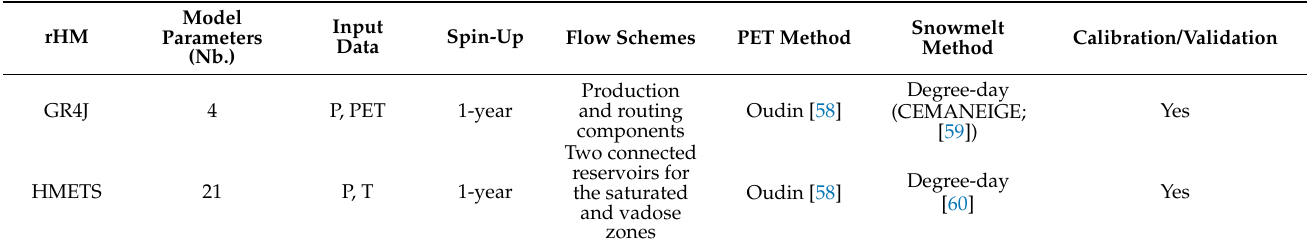
Table 3. Characteristics of the two rHMs used in this study. Each rHM, at the beginning of 1971, was initialized (spin-up) using pre-1970 data (1-year spin-up based on the Princeton data).